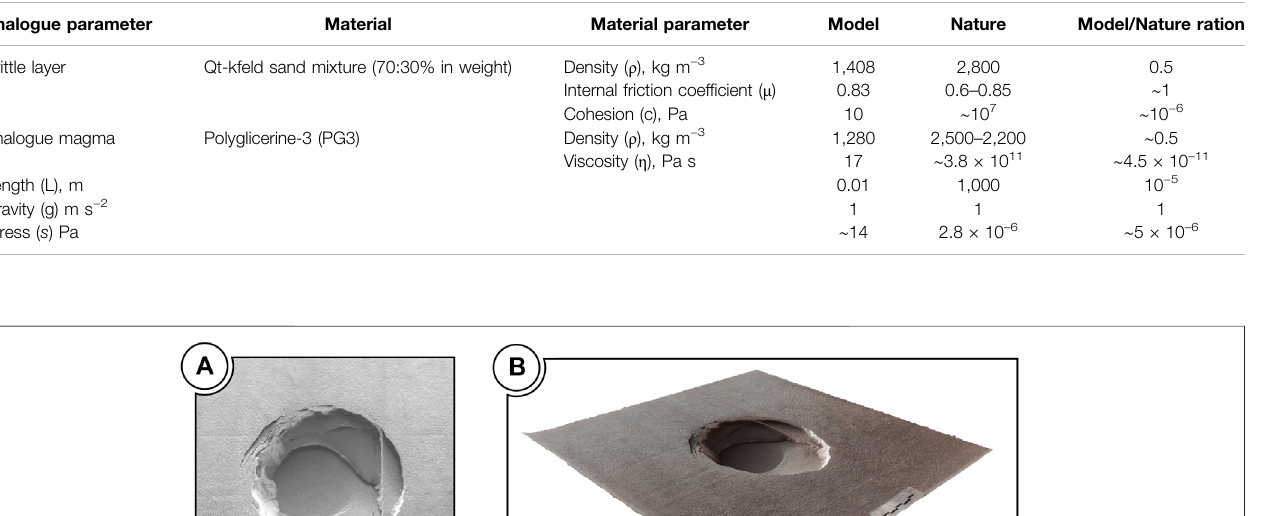
Frontiers in Earth Science |